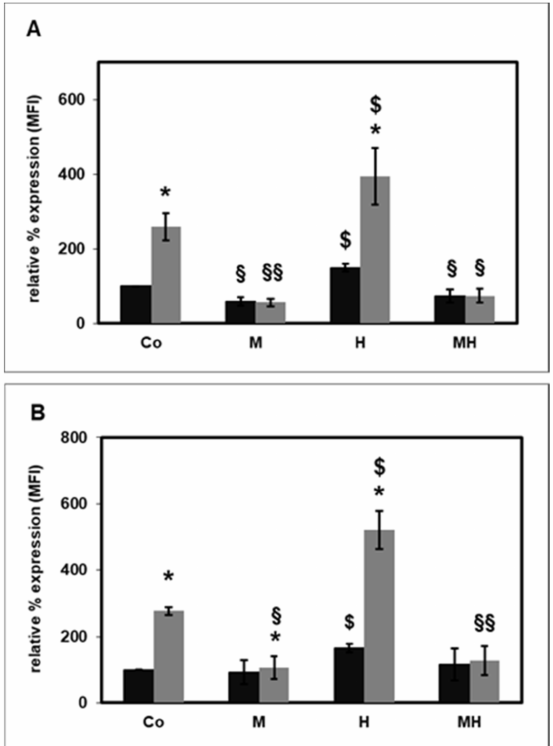
Figure 4. Effect of M β CD (M; 6 mg/mL) on basal (black bars) and fMLP-stimulated (grey bars) CD14 surface expression in the absence and presence of 100 µ g/mL HDL (H) from healthy subjects (( A ); n = 4) and from HD patients (( B ); n = 5). The unstimulated CD11b expression measured as mean fluorescence intensity (MFI) in the absence of M β CD was set as 100%. * p < 0.05 versus the unstimulated values; § p < 0.05 and §§ p < 0.01 versus the absence of M β CD; $ p < 0.05 versus the absence of HDL; data shown are mean values ± SEM.